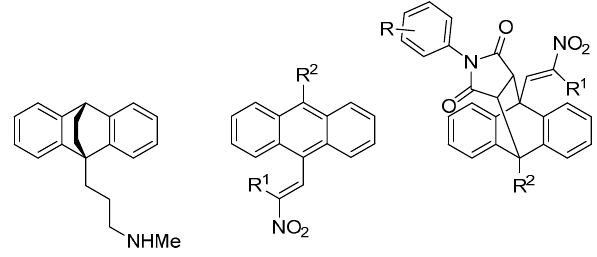
Figure 1. Maprotiline, ( E )-9-(2-nitrovinyl)anthracenes and ethanoanthracene derivatives.